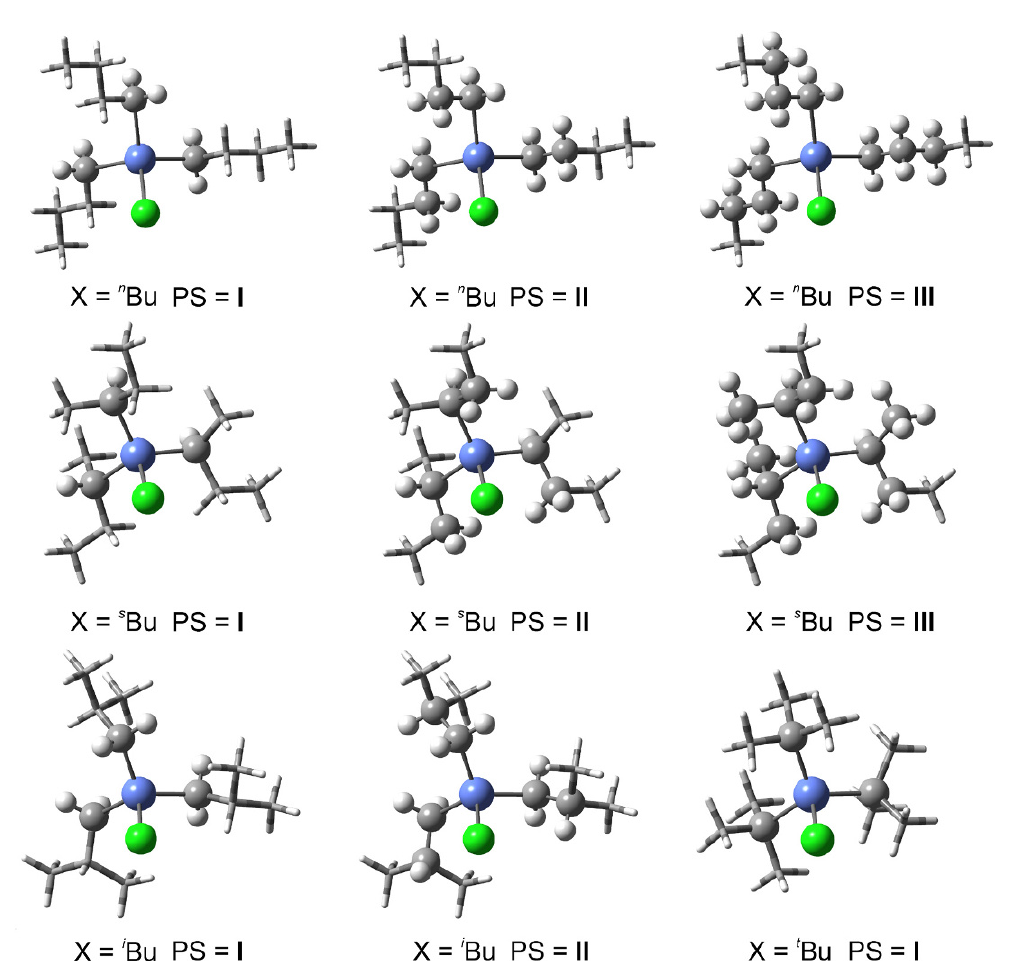
Figure 1. ONIOM partitioning schemes (PS) used for butyltin chlorides. The X SnCl molecules are shown as examples. The fragments of the 3 molecules that belong to the ONIOM core layer are marked using the ‘balls and sticks’ rendering method, whereas the fragments ascribed to the ONIOM surrounding layer are drawn as thick tubes. Carbon atoms are denoted by gray balls/tubes, hydrogen atoms by white balls/tubes, the chlorine atom is colored green and the tin atom is